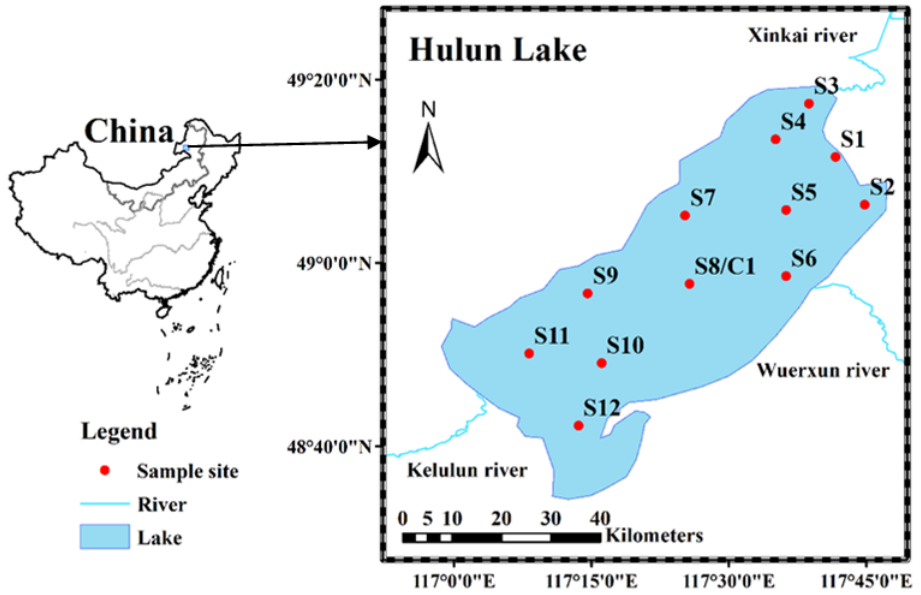
Figure 1. Locations of the sampling sites in Hulun Lake.